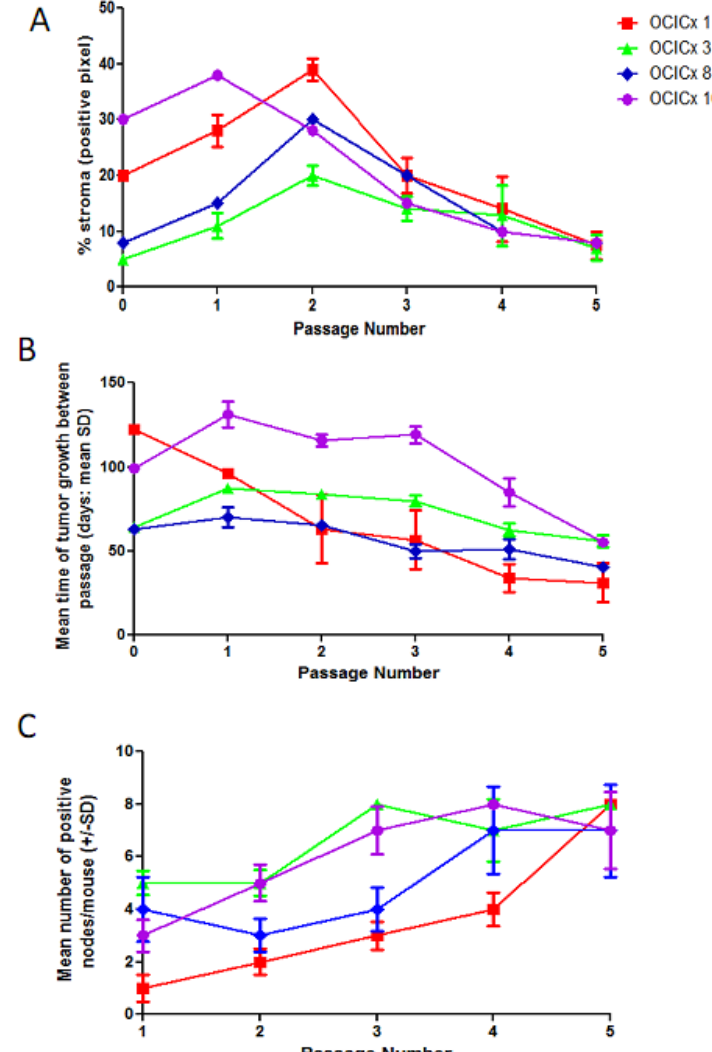
Figure 6. ( A ) Xenograft growth curves for the 4 OCICx models (1, 3, 8, 16) over passage. Tumor growth rates are plotted as function of passage number shown in days (mean time of all the xenografts in the passage ± SD); ( B ) The percent stroma as positive pixel counts over passage number generated by Genie Spectrum software based on the H&E analysis as mean ± SD. Passage number 0 indicates biopsy; ( C ) The mean number (±SD) of positive lymph nodes/mouse is shown for the 4 models over passage